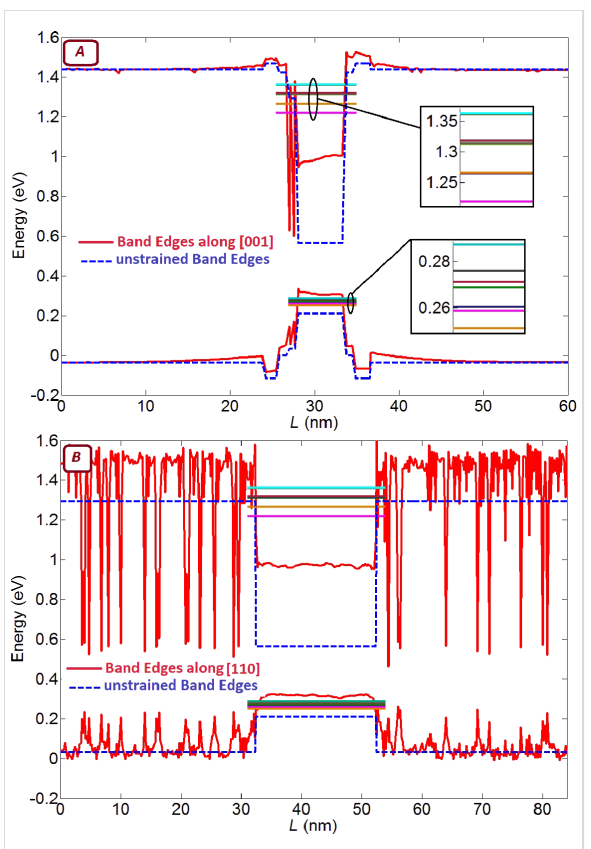
Figure 7: The conduction and valence band edges (solid lines) along a line through the middle of the quantum dot in the (A) [001] and (B) [110] directions. The dashed lines are the band edges of the unstrained bulk materials, drawn to show the significant effect of strain on deforming the band structure. The solid horizontal lines in the quan- tum dots are plotted at the energies corresponding to electron and hole confined states. The noisy red lines in (B) indicate the local band edges in the explicitly represented atomistic alloy. In an atomistic representation of an alloy one obtains an explicitly fluctuating band edge [26].